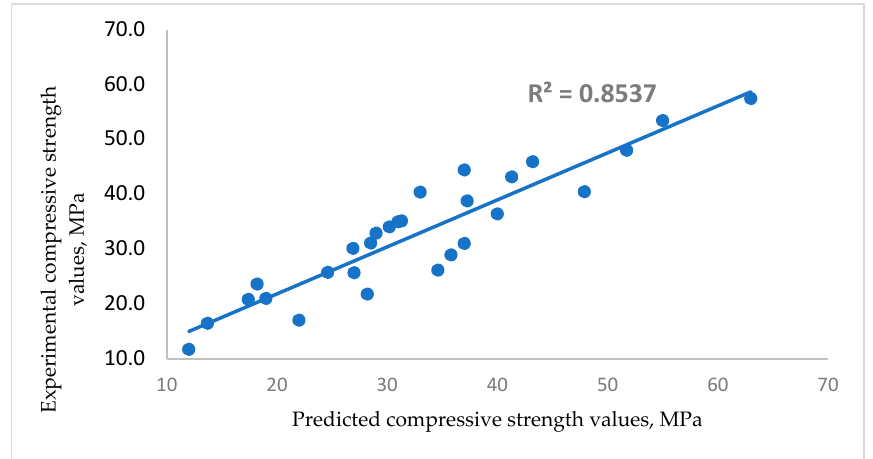
Figure 11. Correlation between experimental and predicted compressive strength values of glass blended concrete.